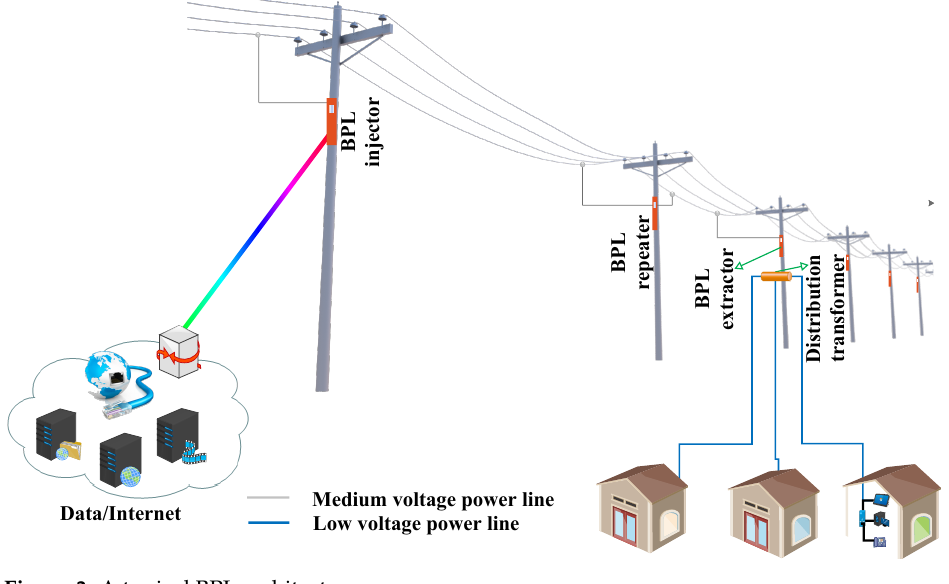
Figure 3. A typical BPL